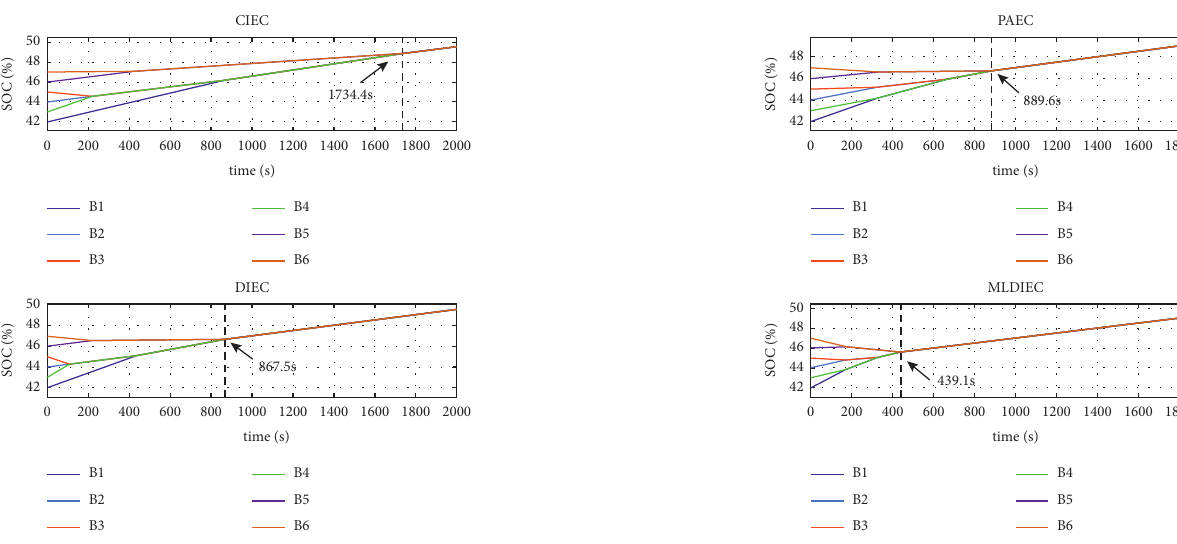
Table 4: Equalization results of the four equalizing circuits in the charging